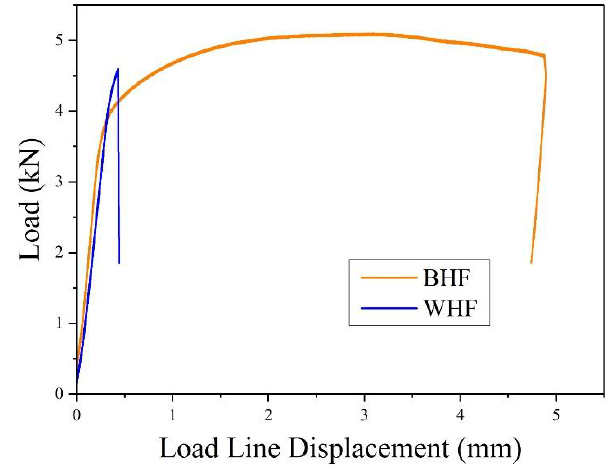
Figure 3. The variation of load with respect to the displacement for hydrogen free specimens.